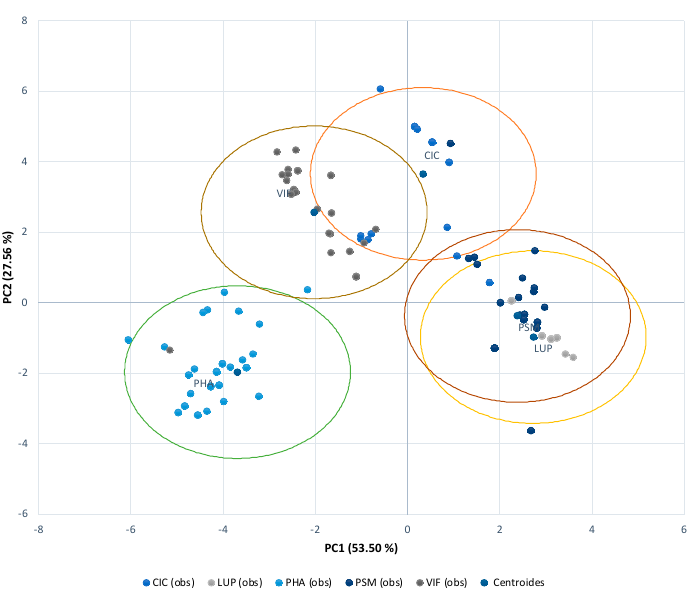
Figure 4. Discriminants of the first (PC1) and second (PC2) principal component analysis (DPCA) scores for the characterization of photothermal parameters among the five grain legume species in both environments. The five groups of species are identified by color. VIF ( Vicia faba ), PSM ( Pisum sativum ), CIC ( Cicer arietinum ), PHA ( Phaseolus vulgaris ), and LUP ( Lupinus spp.). According to these experiments, the combination of changing the sowing date or photoperiod together with the use of adapted legume material would increase the potential average yield. There is a clear genotype × environment effect on yield and flowering time. The best photoperiod-adapted legume genotypes for sowing in SD and LD condi- tions were selected (VIF-0003, VIF-0005, PSM-0112, PSM-0096, PHA-0620, PHA-1160, CIC- 0003, CIC-0006, LUP-0023, and LUP-0028) as shown in Table S4. The selected genotypes were well adapted to SD and LD conditions, with the exception of LUP genotypes, which did not fl ower in LD-ENV2.